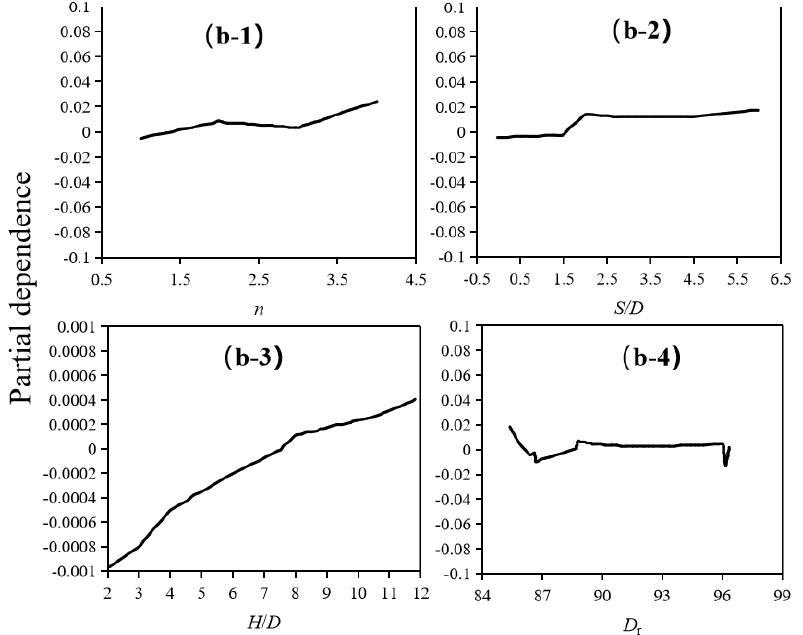
Figure 10. Partial dependence plots of the influencing variables in the optimal GBDT model for predicting: ( a-1 – a-4 ) Q u , ( b-1 – b-4 ) u p .